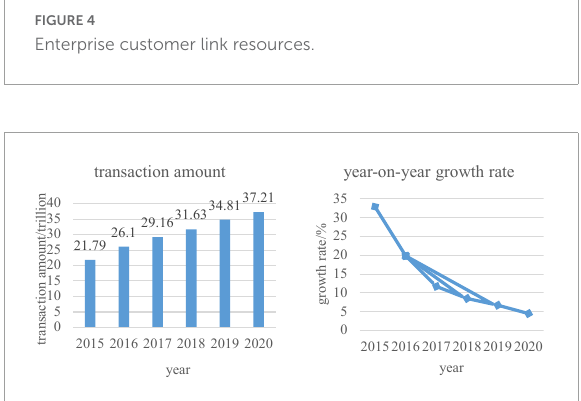
FIGURE4 Enterprise customer link resources.